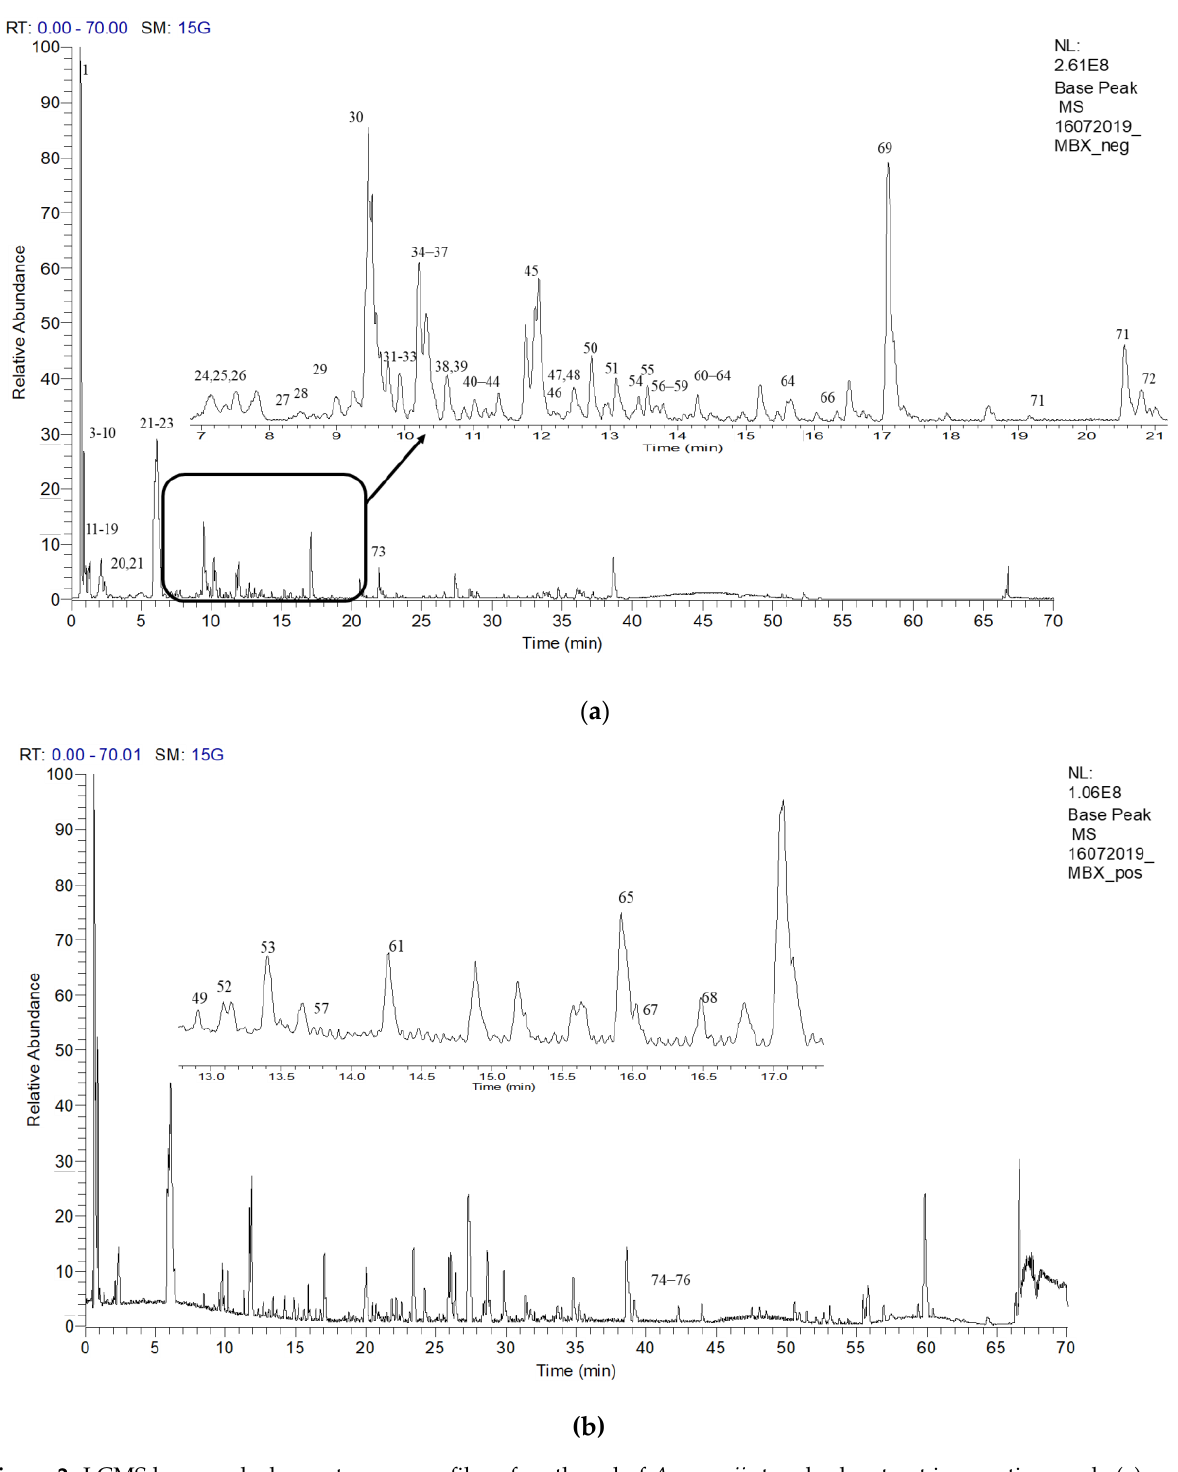
Figure 2. LCMS base peak chromatogram profiles of methanol of A. pavarii stem bark extract in negative mode ( a ) and positive mode ( b ).